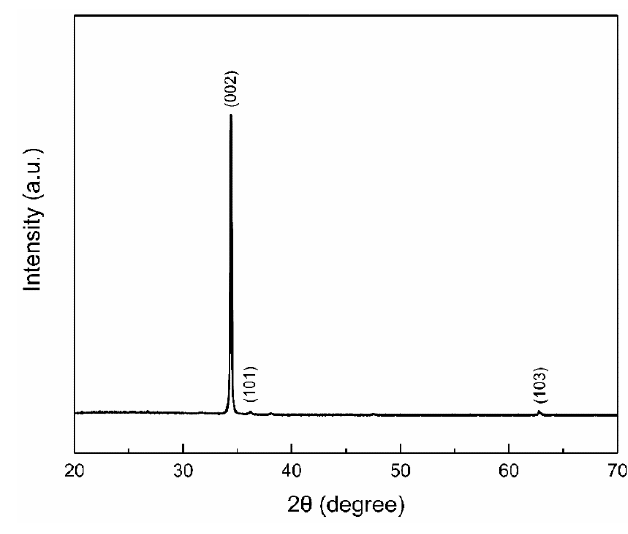
Figure 2. XRD patterns of ZnO NRs.